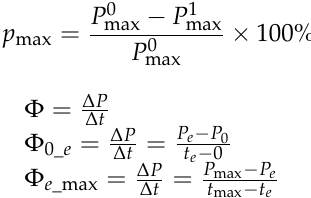
Table 3. Experimental results.